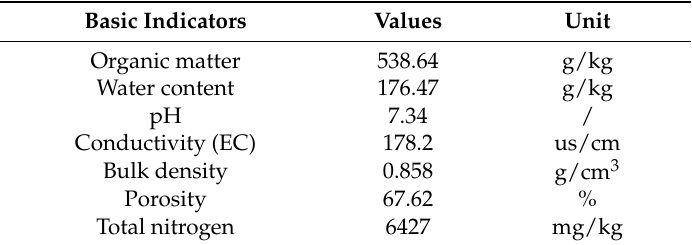
Table 2. Physical and chemical properties of